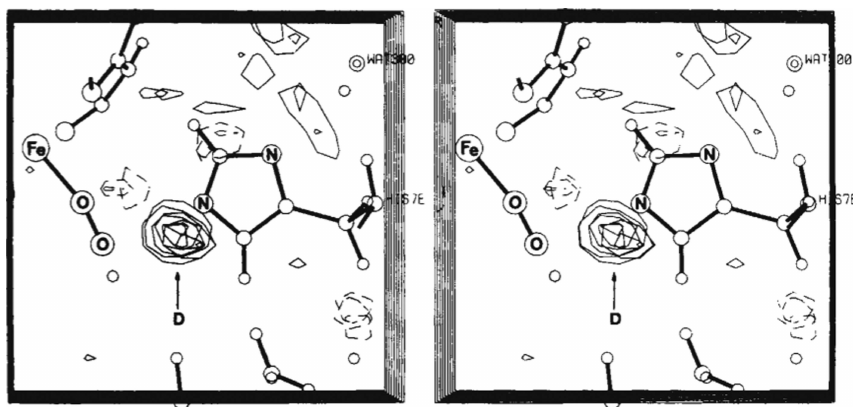
Figure 1 Difference nuclear density demonstrating the protonation of N (cid:4) of the heme-coordinating histidine in myoglobin. Reprinted with permission from Nature Publishing Group: Phillips & Schoenborn (1981), Nature (London) , 292 , 81–82. Copyright (1981) Nature Publishing Group.